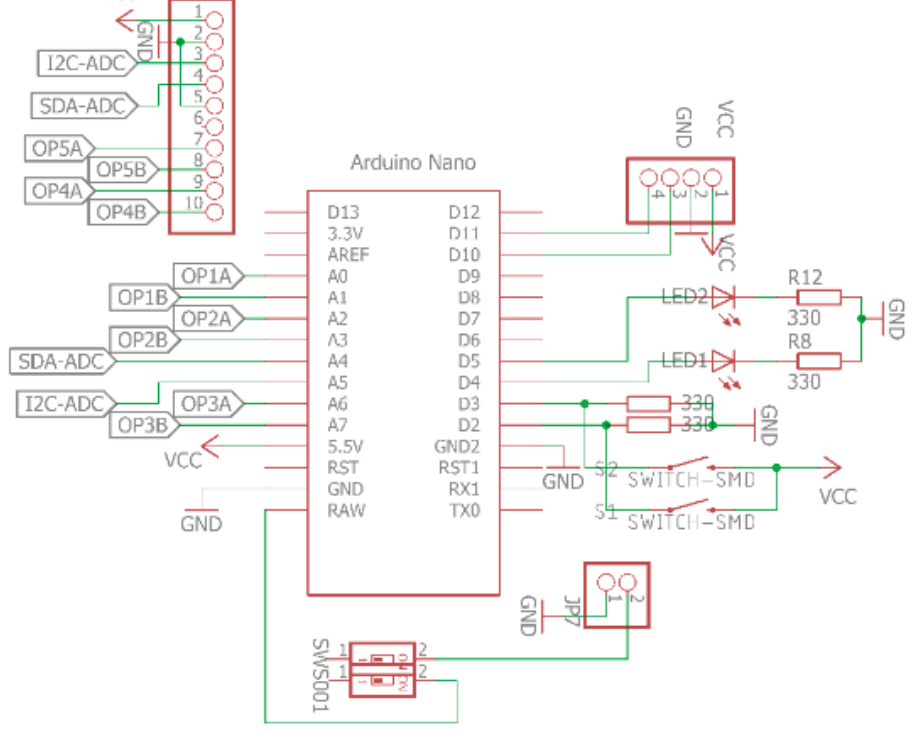
Figure A6. Circuit schematic design.